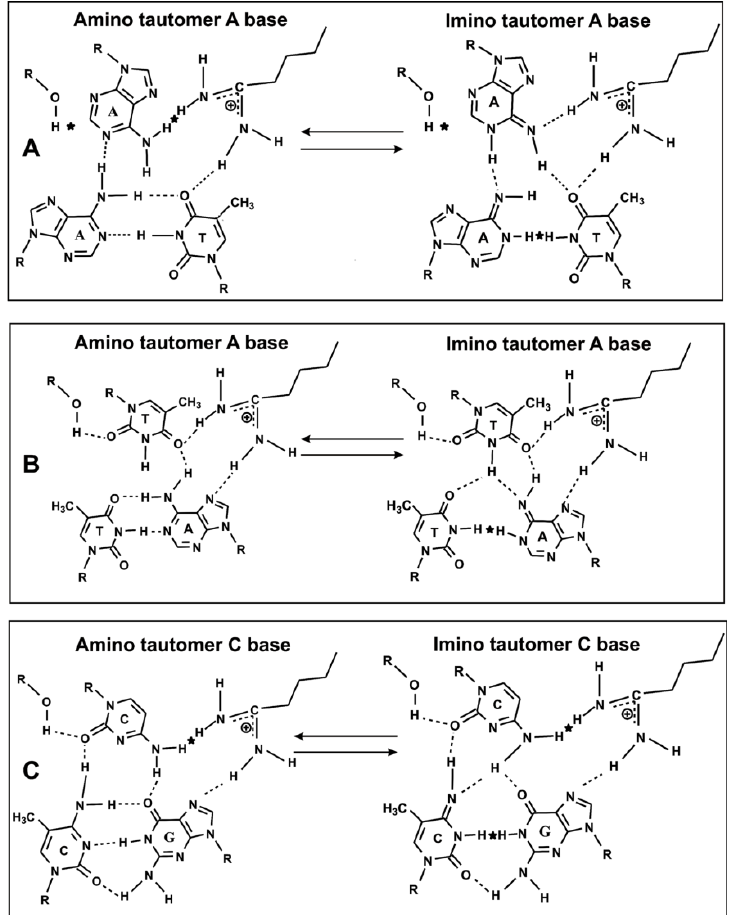
Figure 11. The hypothetical mechanism of homologous exchange catalyzed by RecA, proposed in [87,88]. The binding of ss DNA and the formation of a filament is accompanied by the formation of contacts of the Tyr and Arg RecA residues of the protein with one of the bases of DNA ( A – C ). Subsequent binding of the duplex by the RecA-ss DNA complex and the search for homology is provided due to the formation of specific hydrogen bonds during the formation of the R-DNA triplex. In this case, the RecA protein can catalyze the destruction of Watson–Crick bonds in the duplex due to a shift in the amino–imine equilibrium after the formation of contacts from the one of base with the amino acid residue of the DNA recognition center RecA. The destruction of hydrogen bonds in the original duplex leads to the formation of new ds DNA. The impossibility of hydrogen bonding is indicated using ( ★ ). Tyr and Arg are used in the model as the most appropriate amino acid residues for this role.